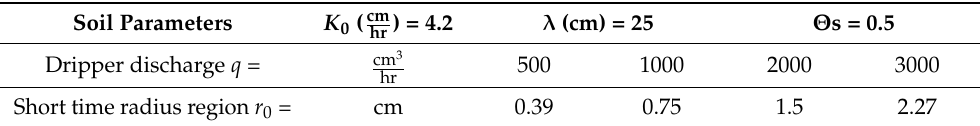
Table 2. Short-times radius of saturated pond using surface drip irrigation.